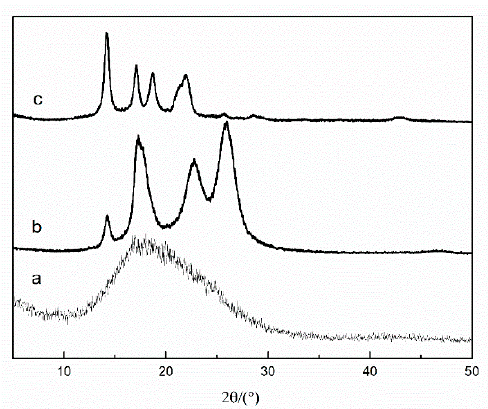
Figure 7. Curves of ( a ) PET fiber, ( b ) MPP-modified PET fiber and ( c ) TMPP-modified PET fiber. Table 1. Diffraction angles (2 θ ), inter-planar spacing (d) and crystallite size (t) of PET fiber, and modified PET fiber.